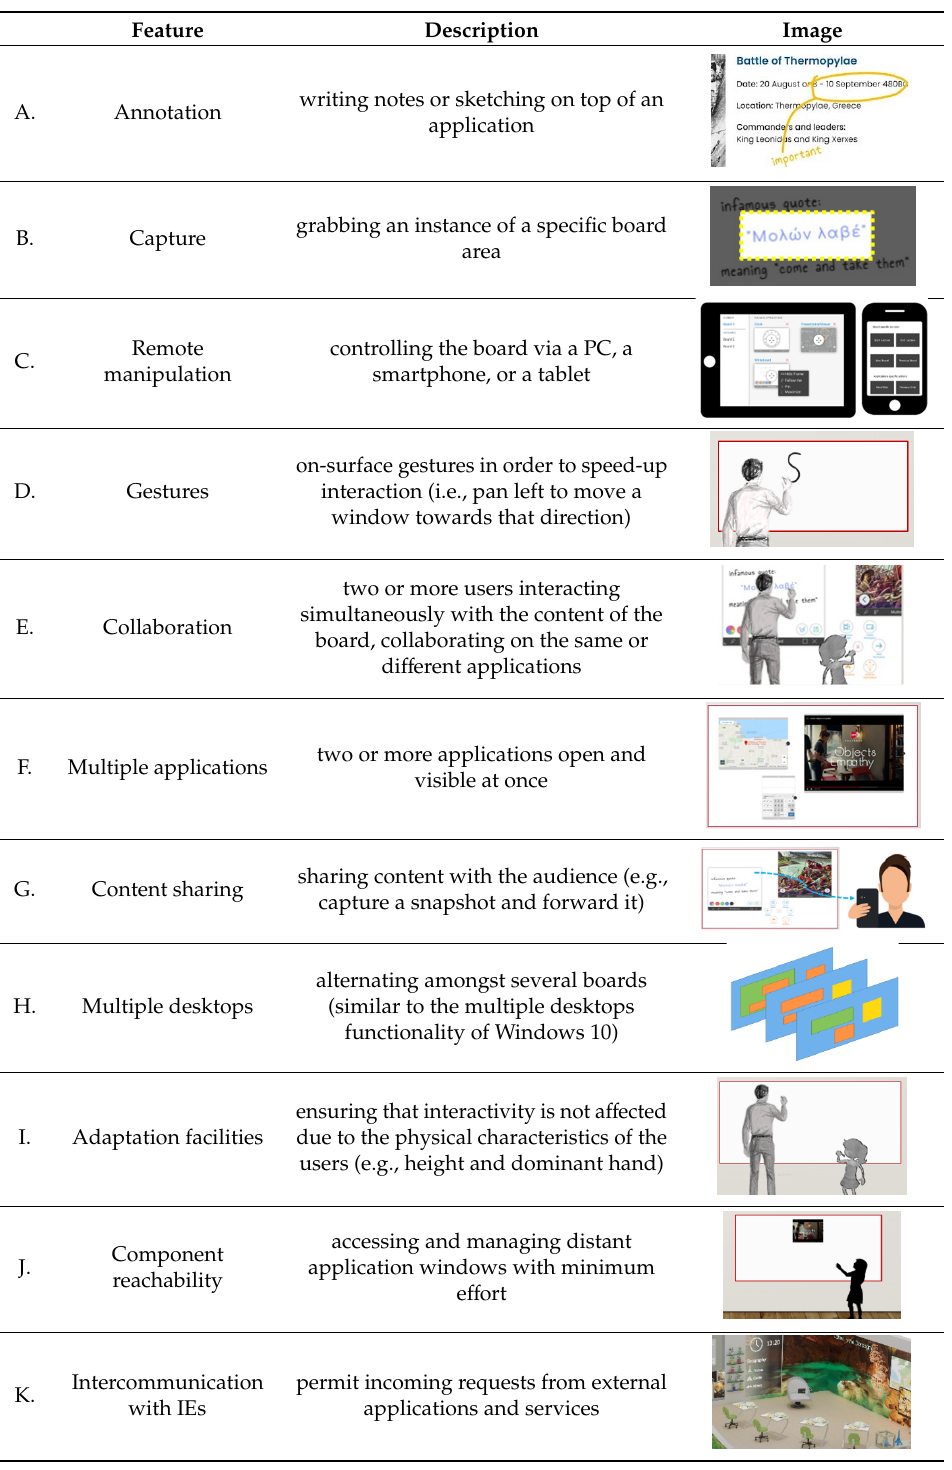
Table 1. Identified features of Interactive